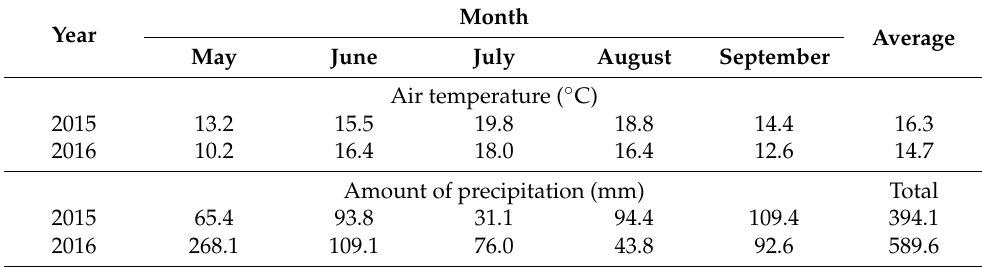
Table 1. Meteorological conditions in the course of experiment.